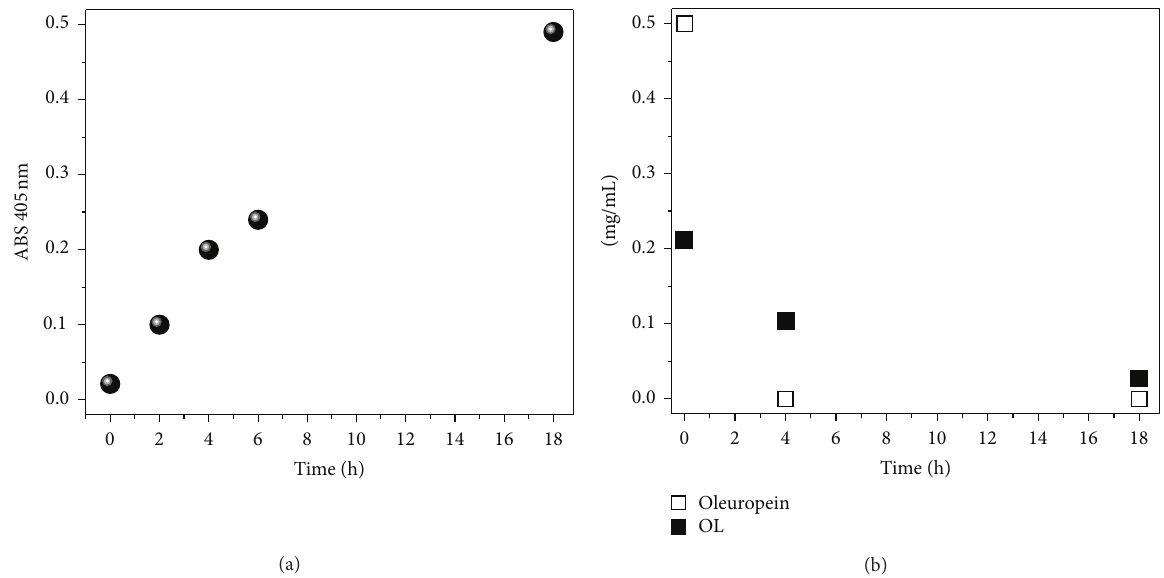
Figure 5: Changes of p-NPG measured by ABS at 405 nm (a) and reduction of oleuropein and olive leaf liquid complex (OL) amounts (b) performed in nutrient-poor medium (NWB-pH 5) by high cell concentration of the L. plantarum B11